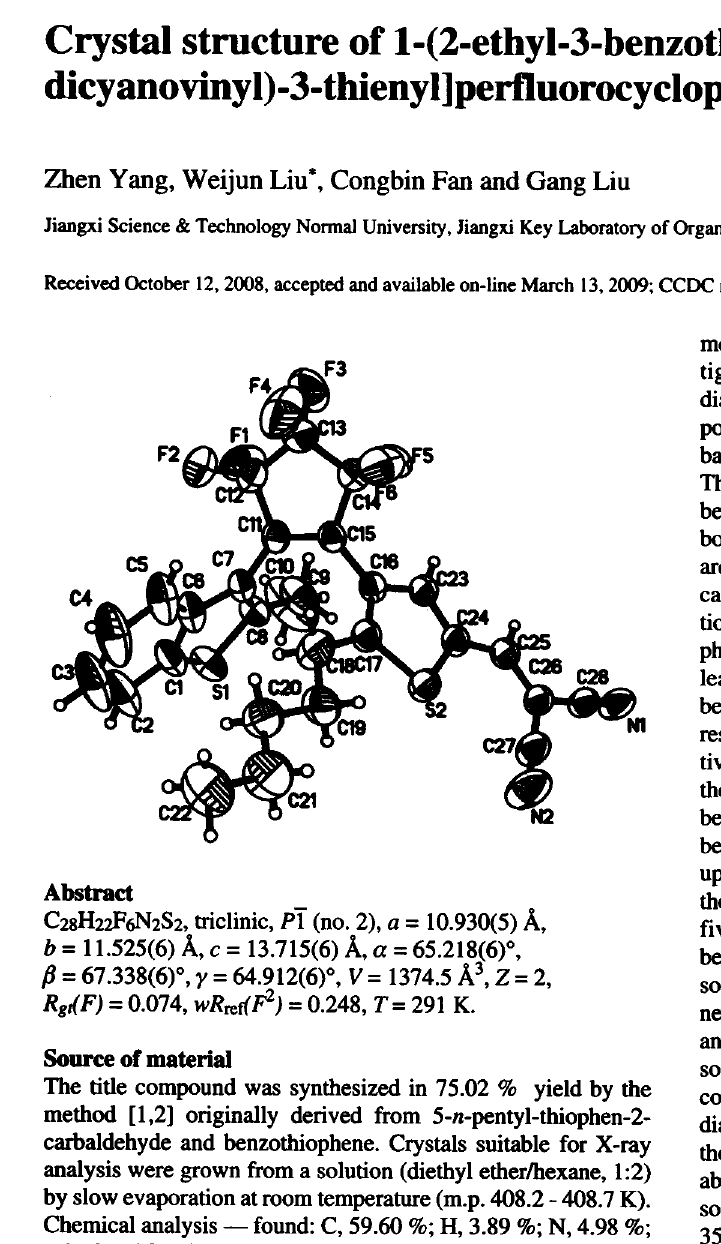
Table 1. Data collection and handling.